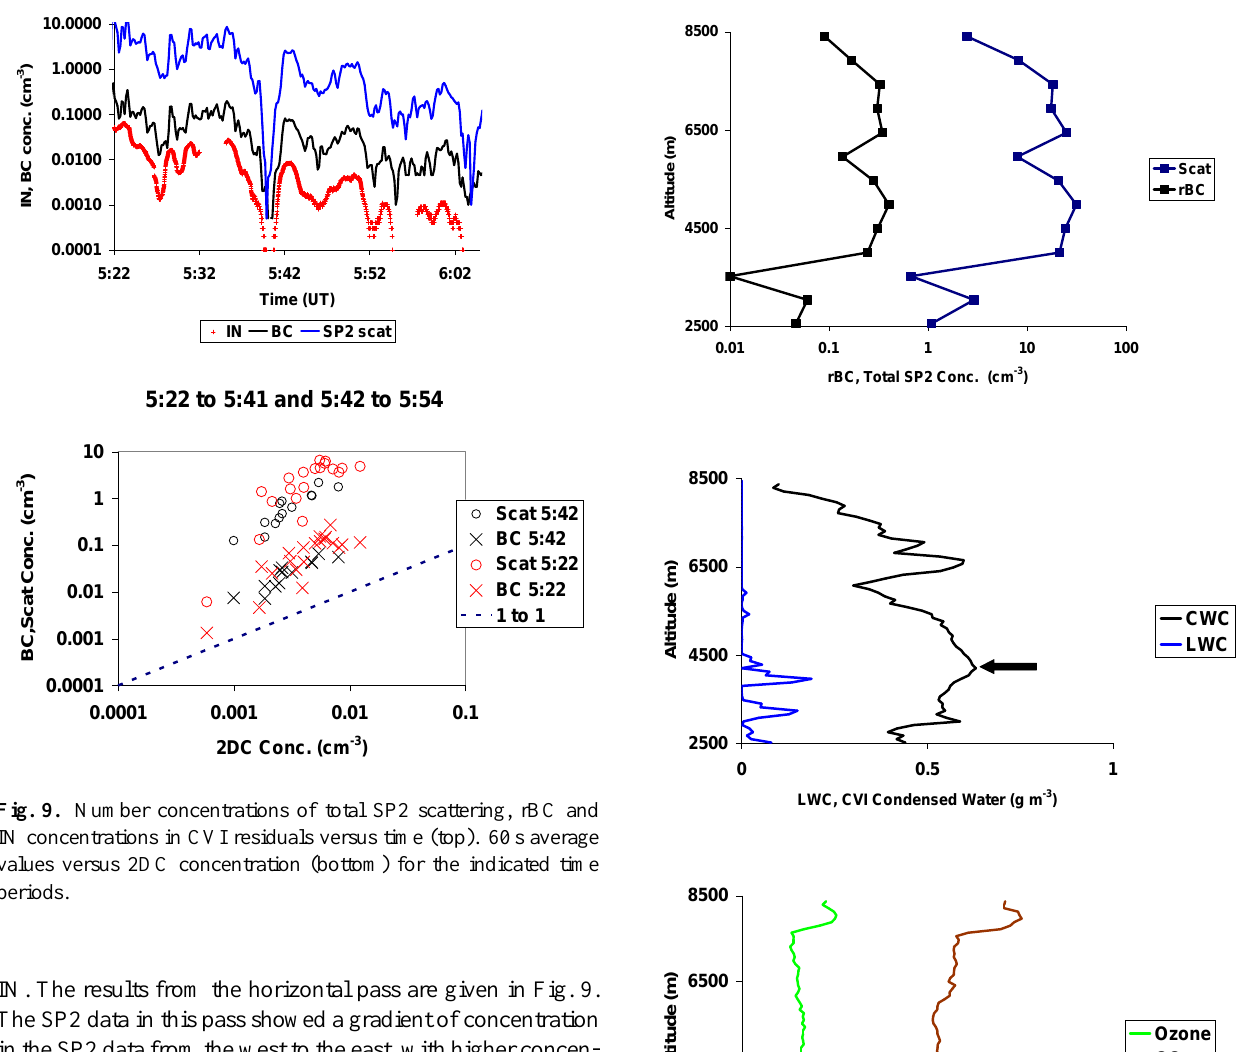
Fig. 5 (8.5 km). Concentrations in the clear air between 06:21 and 06:25 averaged 3.3 cm − 3 and 1.4 cm − 3 for the SP2 total scattering and rBC concentrations, respectively. The nearest in cloud sample from the CVI residuals in the eastern por- tion of the warm sector cloud around 05:56–05:57 indicates